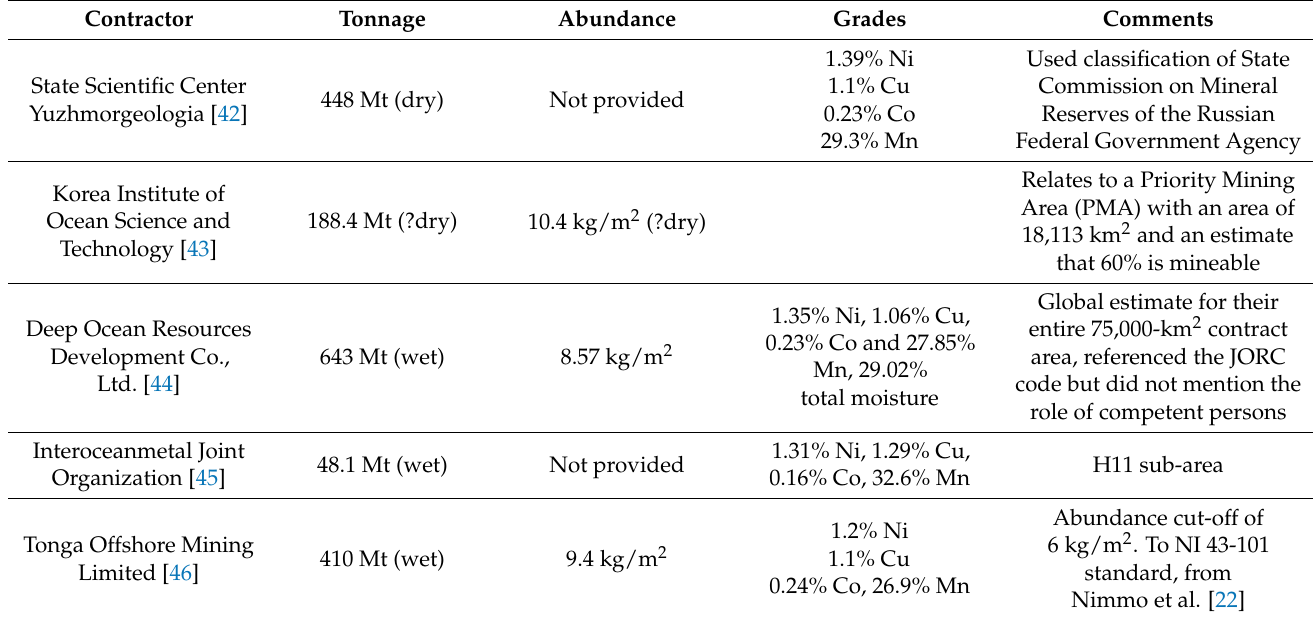
Table 1. Summary of CCZ mineral resource estimates from the ISA 2014